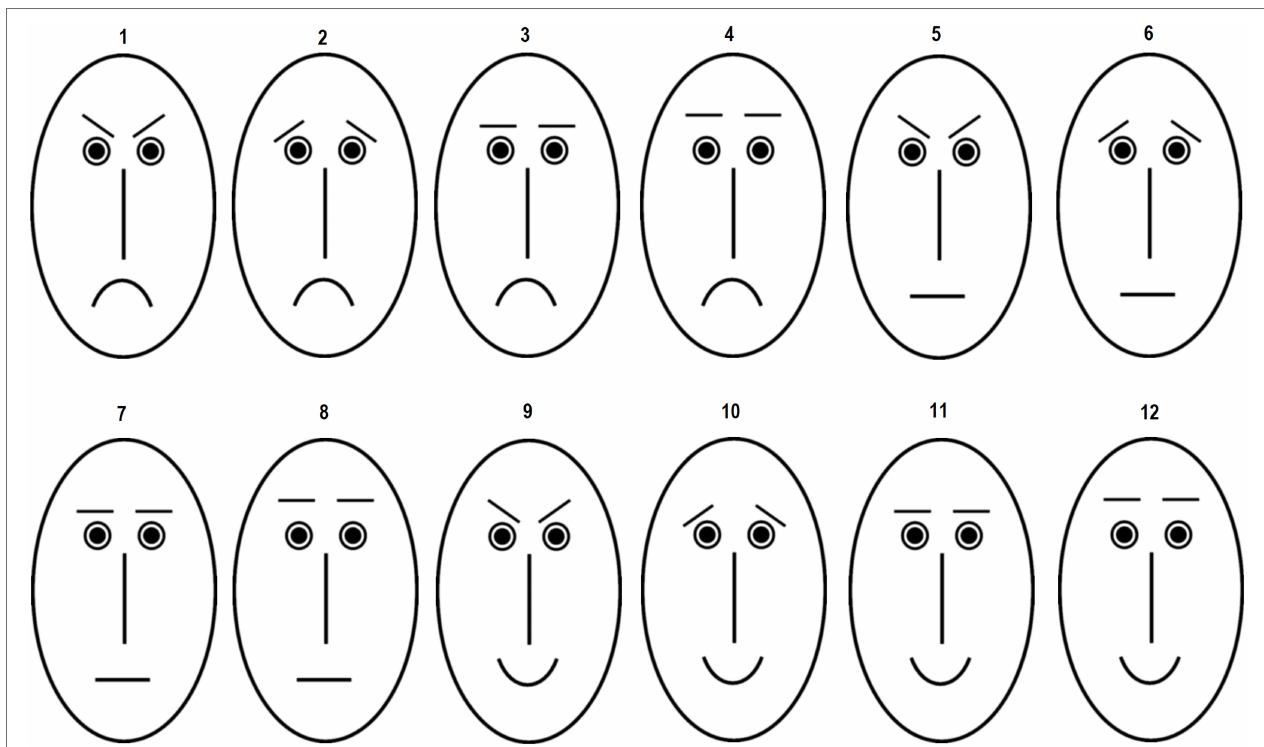
FIGURE 1 | Schematic faces presented in the perception of facial expressions (PFE) task. Faces 1–6 express negative affects. Faces 7 and 8 have a neutral expression and faces 9 and 10 are ambiguous. Faces 11 and 12 express positive affects. Participants had to evaluate each face separately with respect to the degree to which it expresses a certain